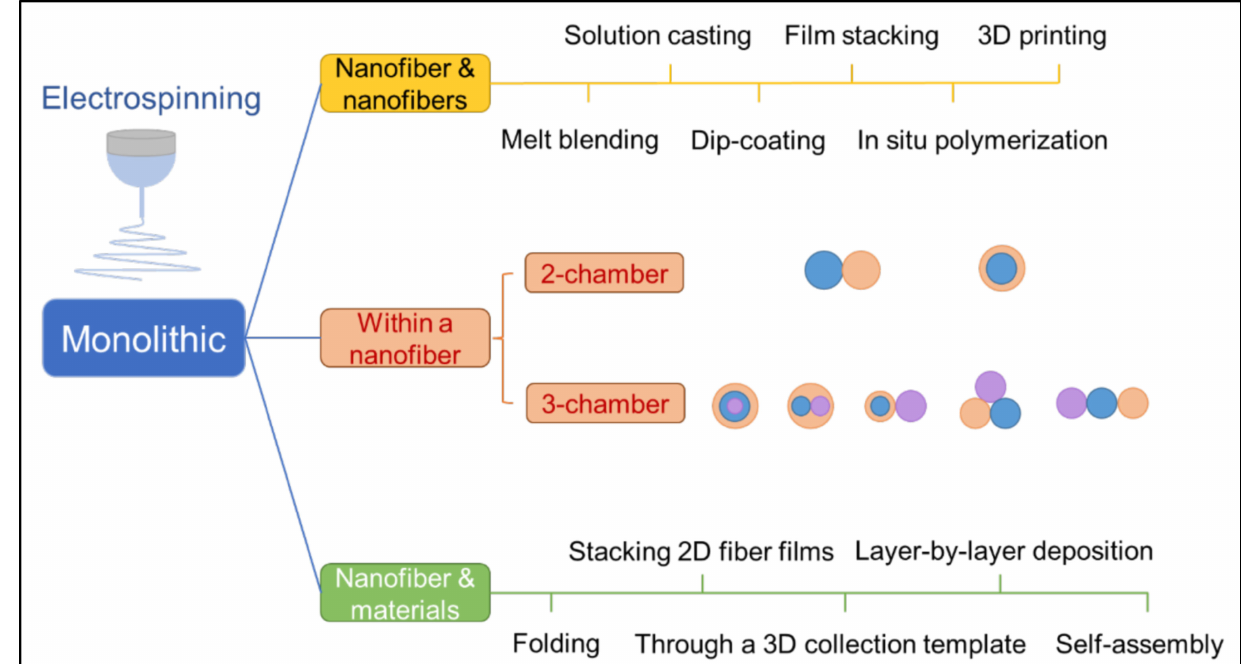
Figure 9. The method of composite nanostructures was developed from uniform nanofibers by improving the electrospinning process, changing the spinneret structure of electrospinning, and combining electrospinning nanofibers with other